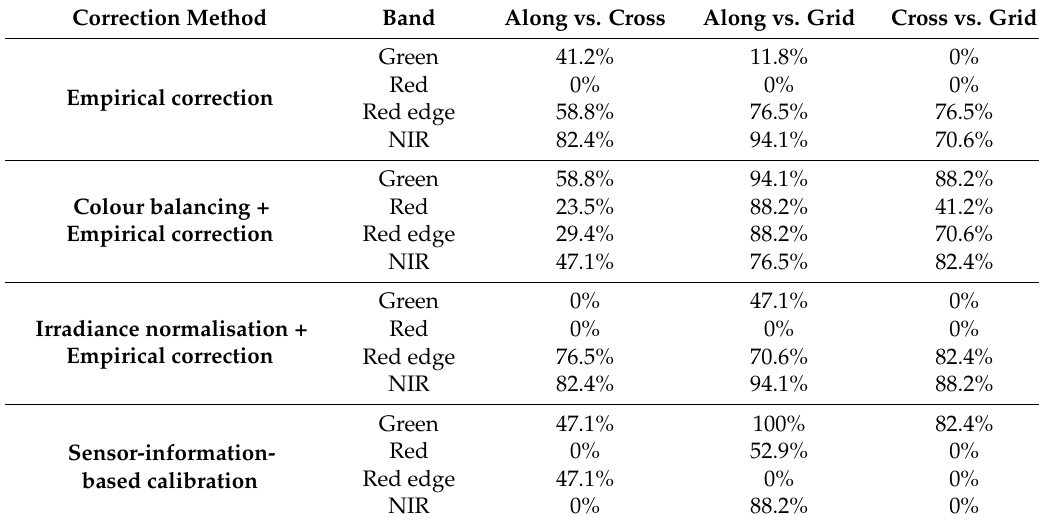
Table A1. Reflectance consistency percentages of tree canopies between different flight patterns in dataset 1.